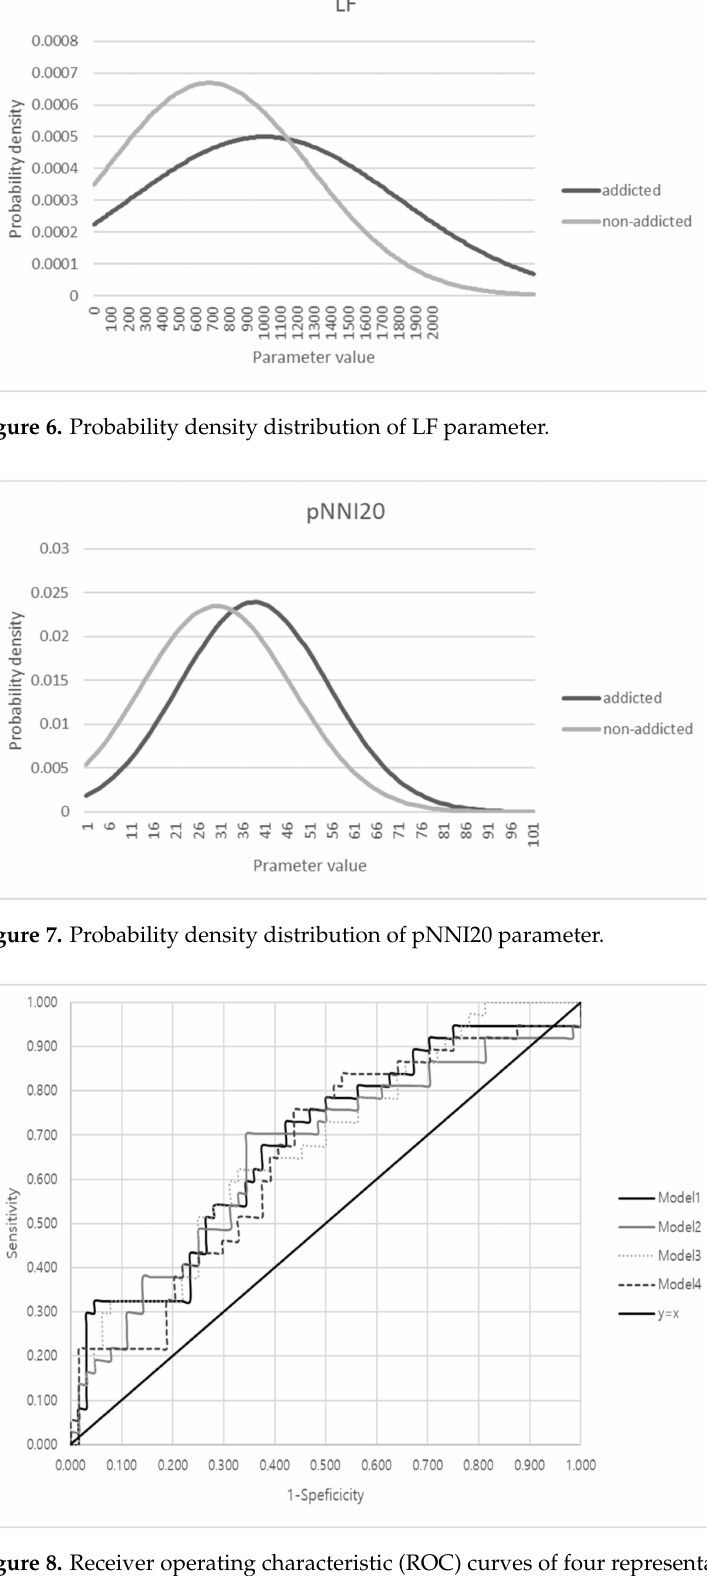
Figure 8. Receiver operating characteristic (ROC) curves of four representative